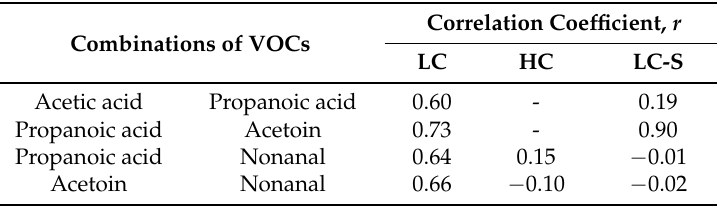
Table 3. Correlation coefficients of four pairs of VOCs. Correlation Coefficient, Combinations of VOCs